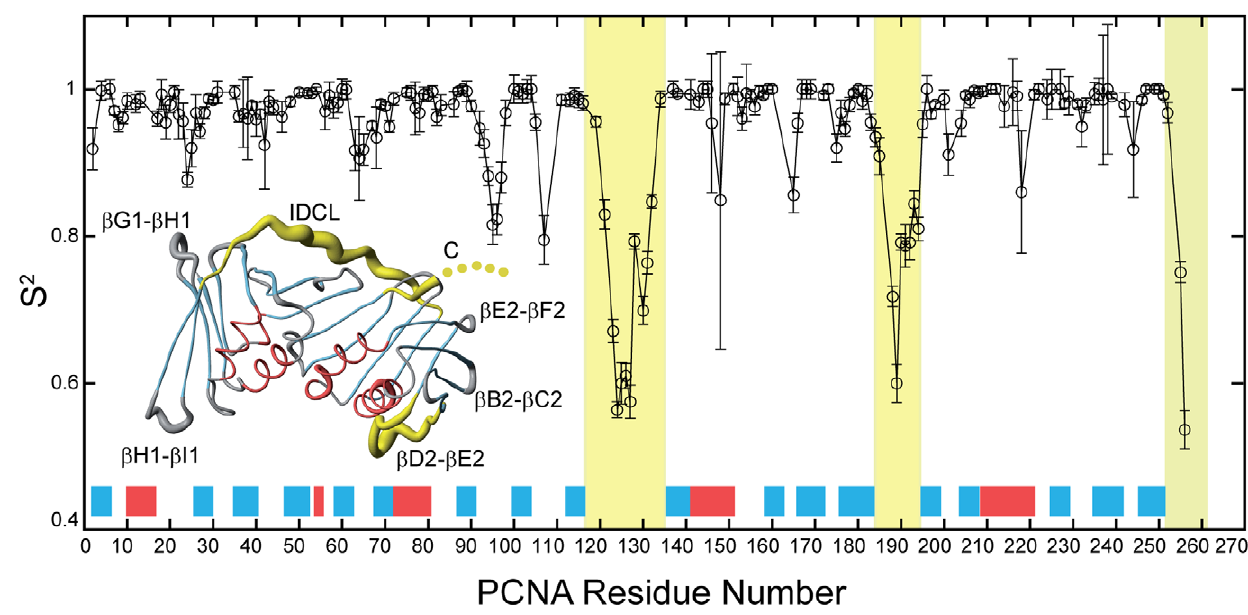
Figure 2. Internal backbone dynamics of PCNA in solution measured by 15 N relaxation. The order parameter S 2 for backbone HN bonds are plotted for those residues whose 15 N T 1 , T 2 , and 15 N{ 1 H} NOE values could be measured and analyzed. The location of the secondary structure elements along the PCNA sequence is indicated by red and blue boxes for a -helices and b -strands, respectively. The last five residues at the C- terminal end are not seen in the crystal structure and therefore an order parameter was not calculated, but these residues have the smallest heteronuclear NOEs and the largest T 2 times, indicating that they are the most flexible residues in the protein (see Figure S1). The regions of the graph corresponding to the IDCL (residues 117–134), the b D2 2 b E2 loop (184–195), and the C-terminus (252–261) are shaded in yellow. Inset: Representation of the PCNA backbone structure as a coil whose thickness is proportional to the order parameter S 2 of the backbone NH bond of the corresponding residue. For simplicity only one of the protomers is shown, but the data correspond to measurements done on the homotrimer. For the residues whose order parameter could not be calculated the thickness was interpolated based on the solid line joining the available values plotted in the graph. Helices and strands are colored in red and blue, and the three most flexible regions are colored in yellow (as in the graph). The loops with high relative disorder are labeled using the same nomenclature as in Figure 1. doi:10.1371/journal.pone.0048390.g002 superimposed on the corresponding residues of free PCNA in the PDB file 1W60. The RMSD for the same atoms and residues is 1.63 A˚ when the superimposition is done using the free PCNA structure 1VYM.